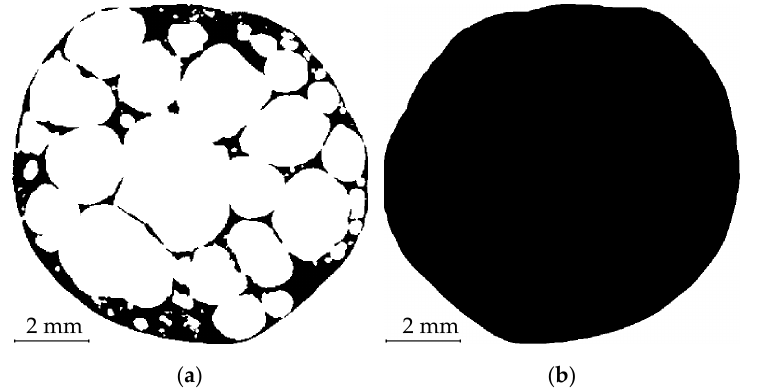
Figure 5. Binarised APM foam sample transversal slice with pores opened to the outside ( a ) and a filled APM foam cross-section using the developed filtering procedure ( b ).